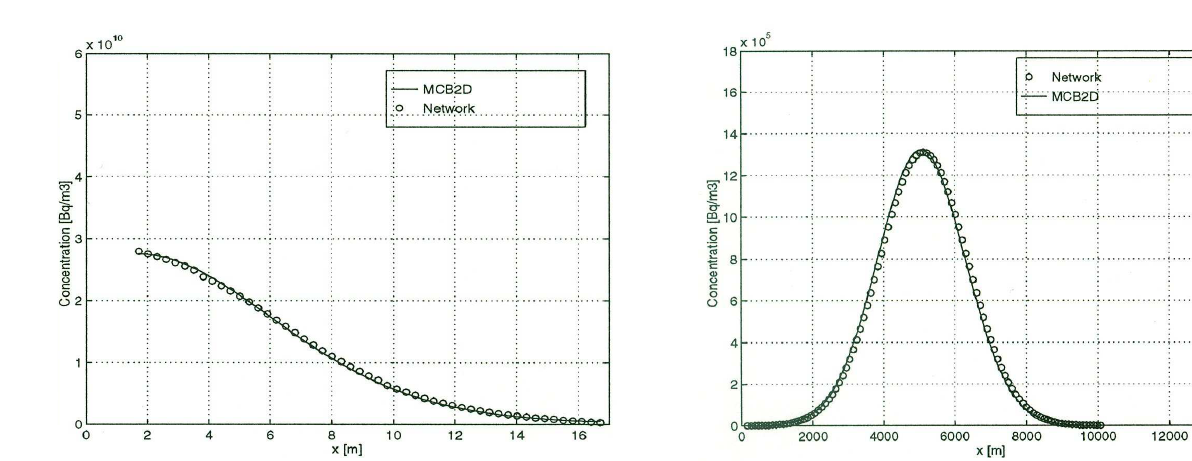
Fig. 4.3. Network 3, v/R=1.12 (cid:215) 10 -3 m/d, e test=12.9%